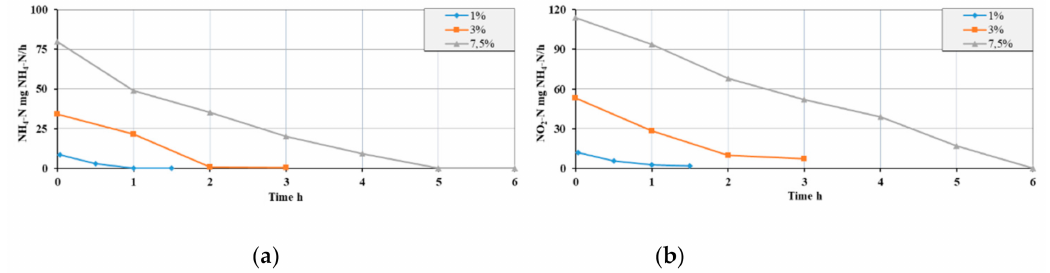
Figure 4. Concentration values of ( a ) NH 4 -N ( b ) NO 2 -N for the process carried out with 1%, 3% and